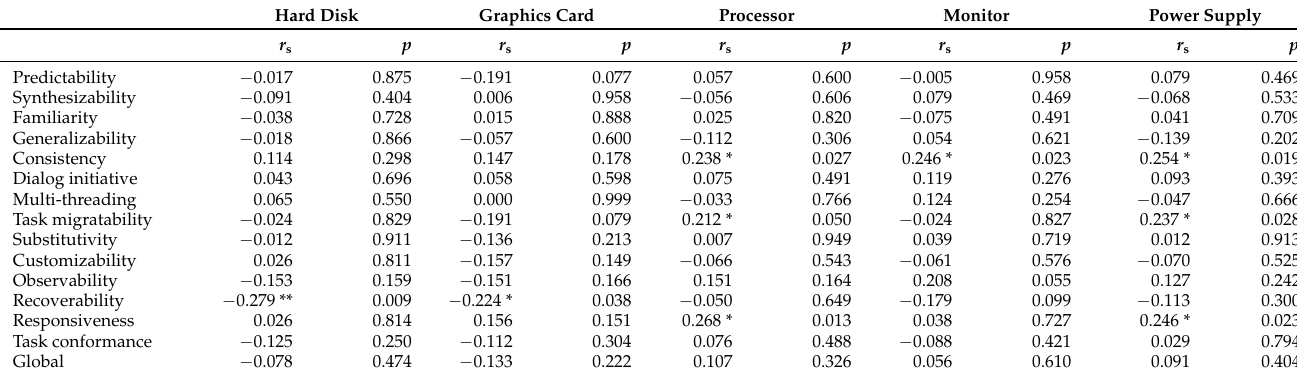
Table 3. Spearman’s correlations between power in watts and usability evaluations (Likert scale). Hard Disk Graphics Card Processor